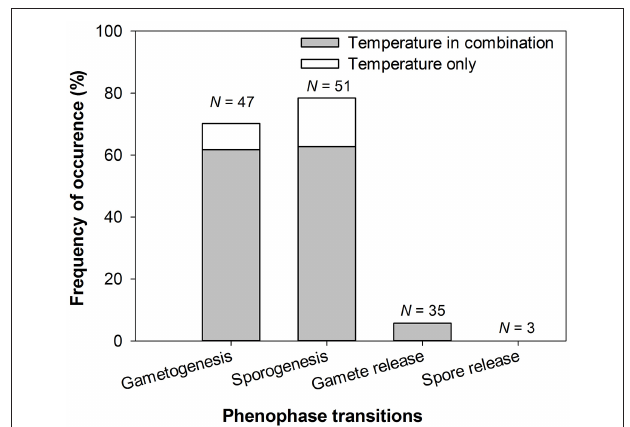
FIGURE 3 | Occurrence of temperature as driver of reproductive events for each phenophase transition (gametogenesis, sporogenesis, gamete release, spore release), alone or in combination with other factors. N, number of reproductive events (136 reproductive events in total controlled by environmental/endogenous factors from 81 papers, totalling 71 seaweed